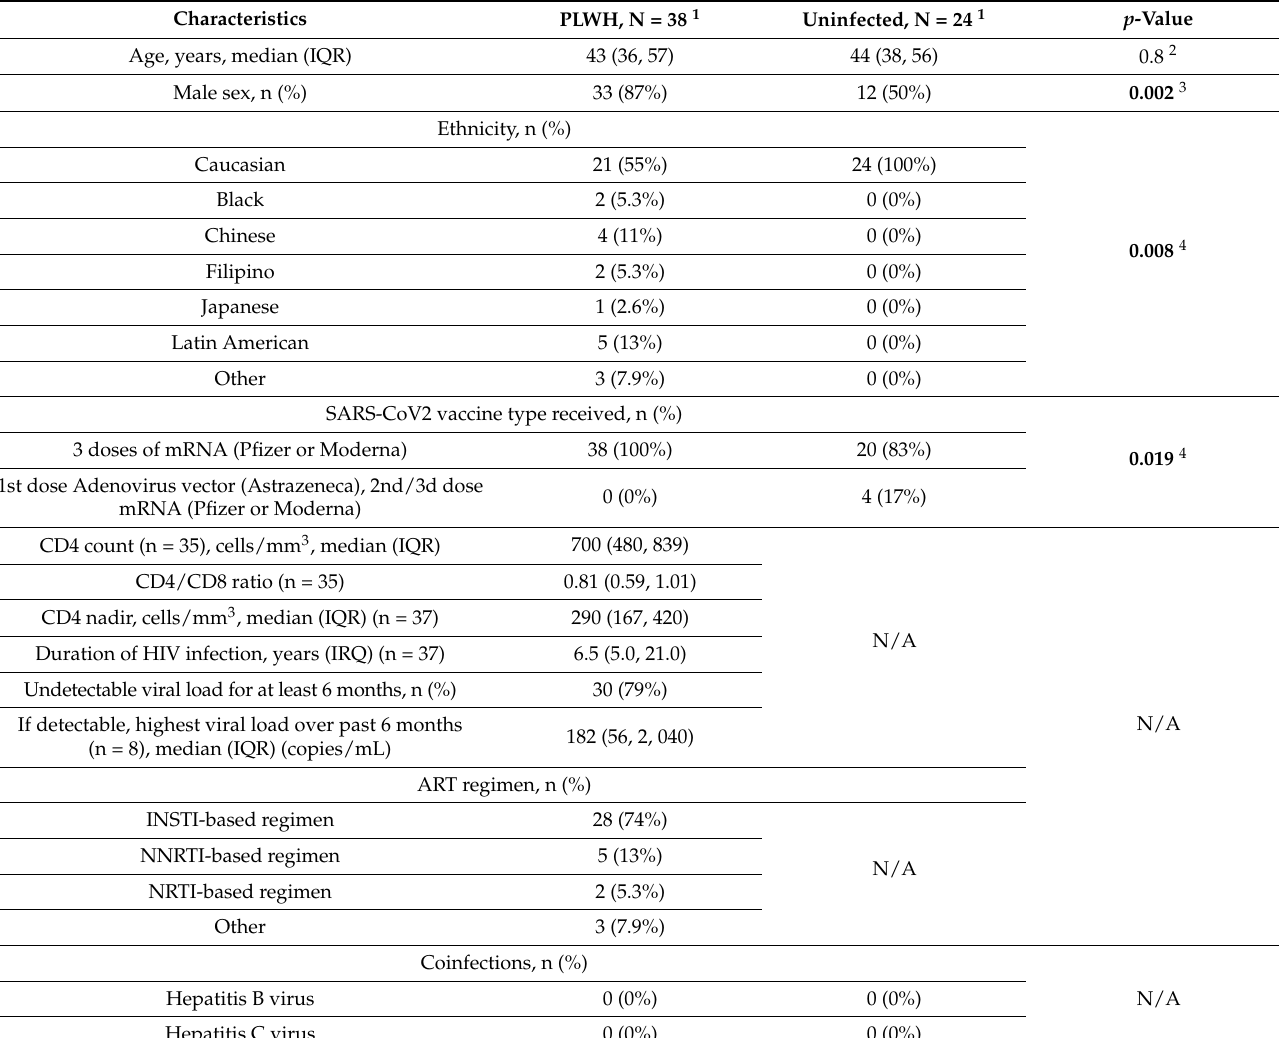
Table 1. Participant characteristics. INSTI = integrase strand inhibitor; NNRTI = non-nucleoside r verse transcriptase inhibitor; NRT = nucleoside reverse transcriptase inhibitor. Significant differences ( p < 0.05) are highlighted in